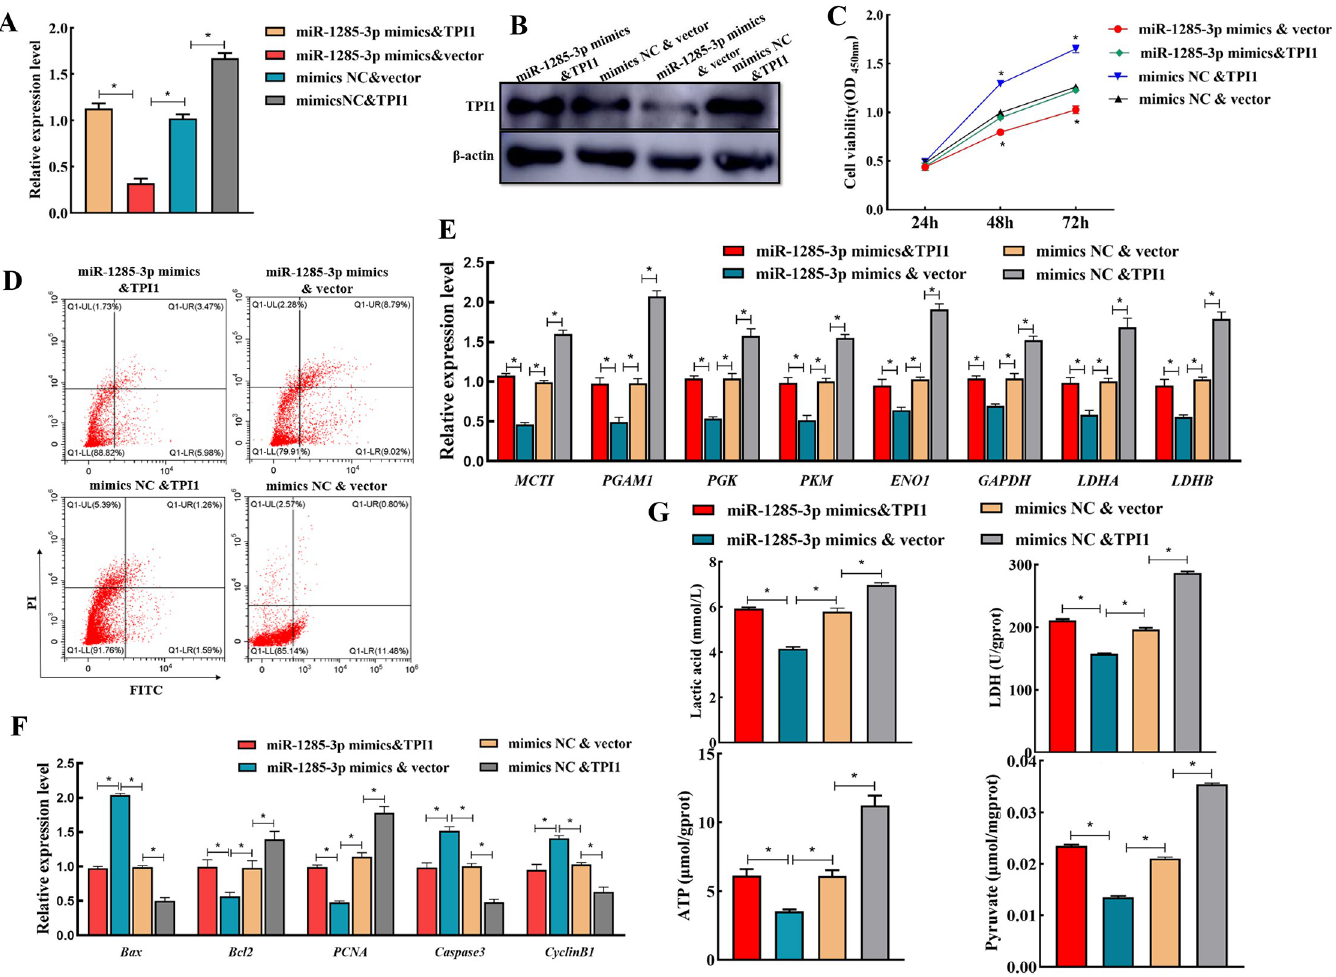
Fig 7. Effect of miR-1285-3p on SCs glycolytic metabolism by targeting TPI1 in rescue experiment. A, B: RNA and protein level of TPI1 were detected by qRT-PCR and western blot, respectively. C, D and F: SCs proliferation and apoptosis detected by CCK-8, Flow cytometry and the expression of proliferation, cycle and apoptosis related genes. E, G: The expression levels of downstream genes and the content of glycolytic metabolic pathway products, energy and key enzymes of SCs.